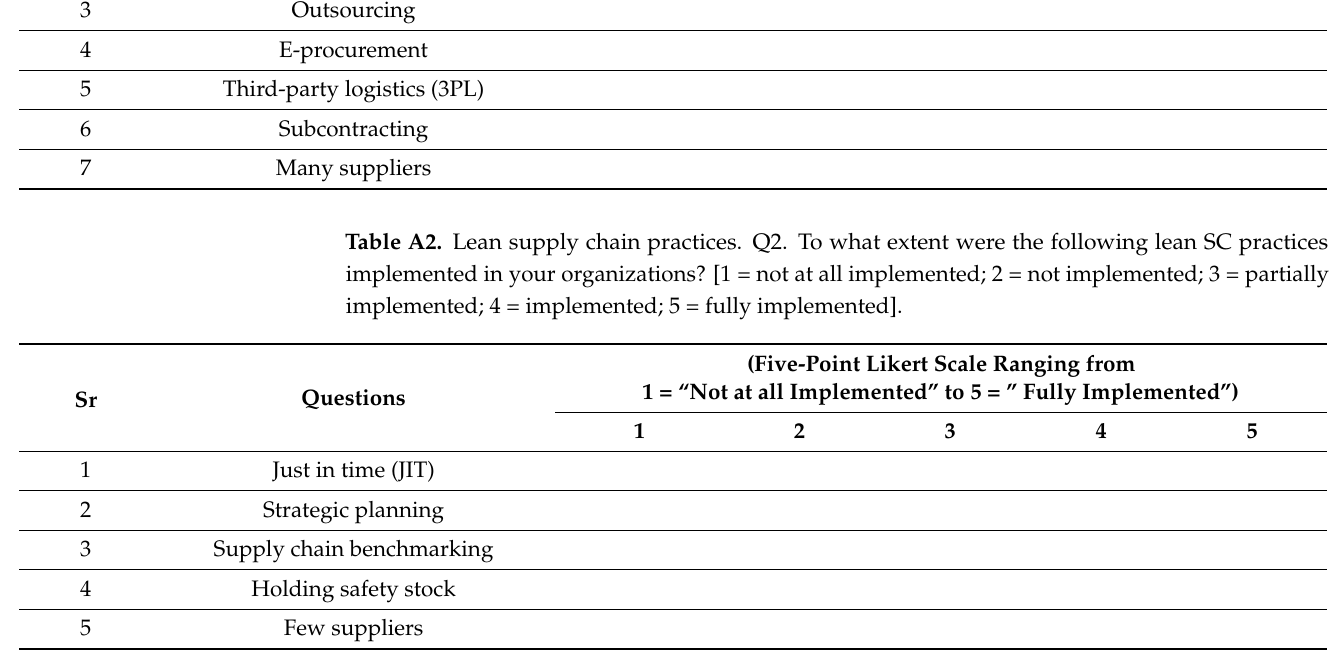
Table A3. Supply chain-related firm performance. Q3. How did your business perform over the